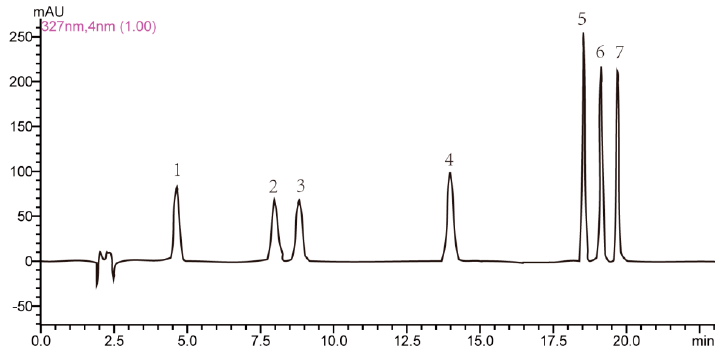
Figure 2. HPLC-PDA chromatogram of (1) 5-caffeoylquinic acid; (2) 3-caffeoylquinic acid; (3) 4-caffeoylquinic acid; (4) 1,3-dicaffeoylquinic acid; (5) 3,4-dicaffeoylquinic acid; (6) 3,5-dicaffeoylquinic acid; (7) 4,5-dicaffeoylquinic acid. Table 1. Regression data, limits of detection (LODs), lower limit of quantification (LLOQs) for seven CQAs. Compounds